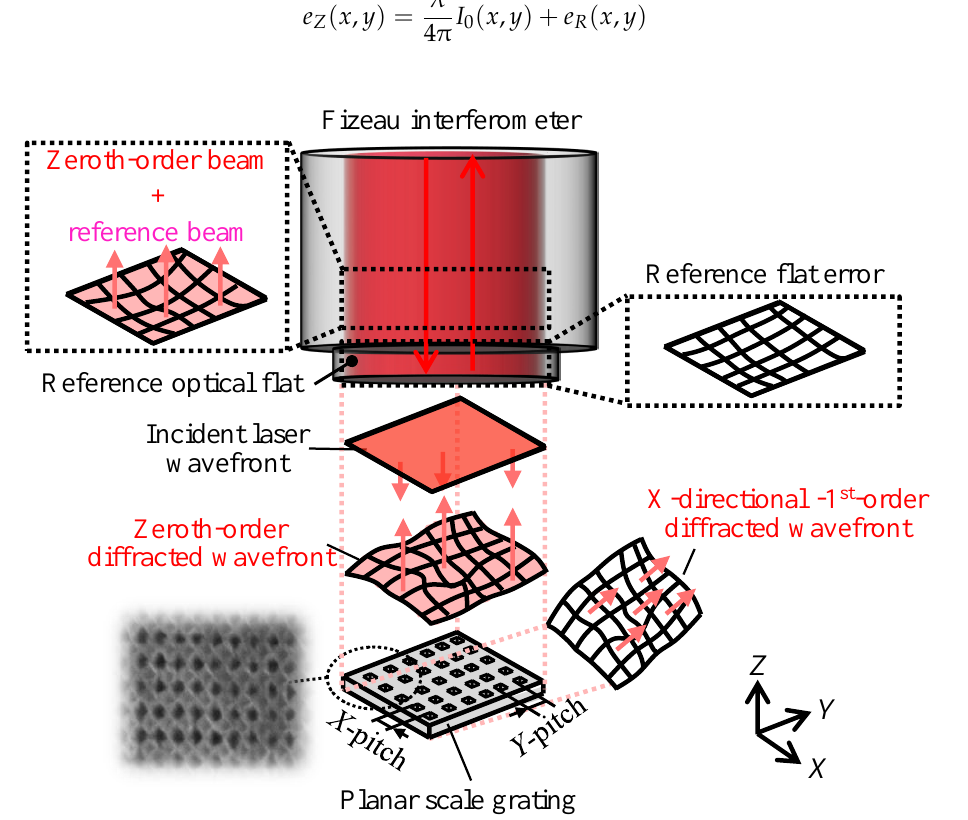
Figure 1. Measurement of zeroth-order diffracted wavefront using Fizeau interferometer (positive first-order diffracted wavefront is not shown for the sake of simplicity).